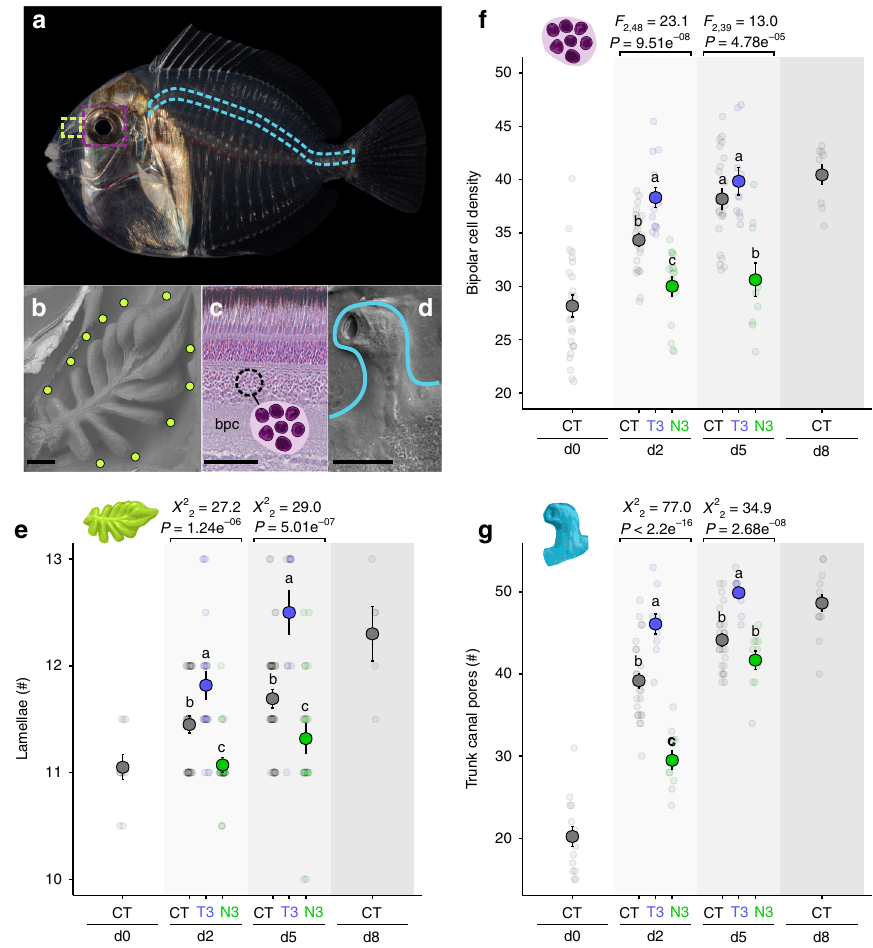
Fig. 1 Development of sensory structures in Acanthurus triostegus at recruitment. a Metamorphosing larva of A. triostegus (standard length = 2.5 cm). Left-to-right dotted-areas indicate the regions where b, c and d, are found, respectively. b Scanning electron microscope (SEM) photograph of an olfactory organ rosetta, with 11 lamellae (green dots). Scale bar: 100 µ m. c Cross-section in the retina presenting the bipolar cells (bpc) region. Scale bar: 50 µ